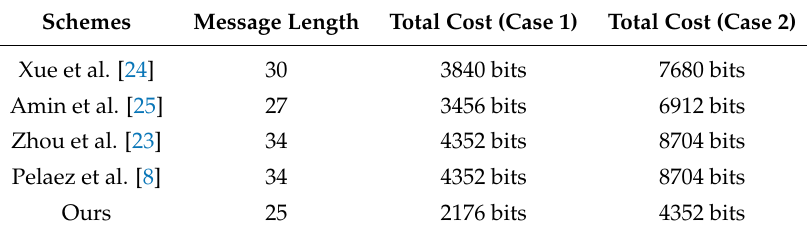
Table 4. A comparative summary: communication